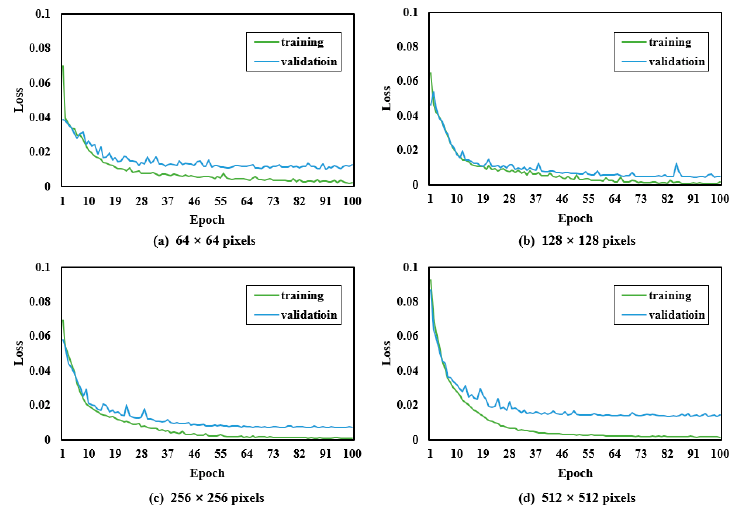
Figure 3. Loss curves of the proposed model for training and validating the datasets in four input patch sizes.